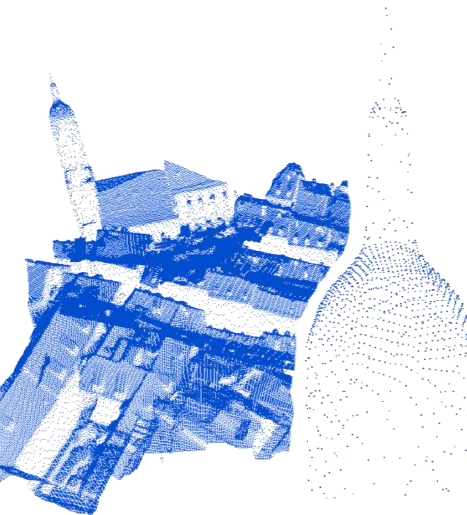
Figure 4. High resolution 3D point cloud generated by the dense matcher module of UltraMap